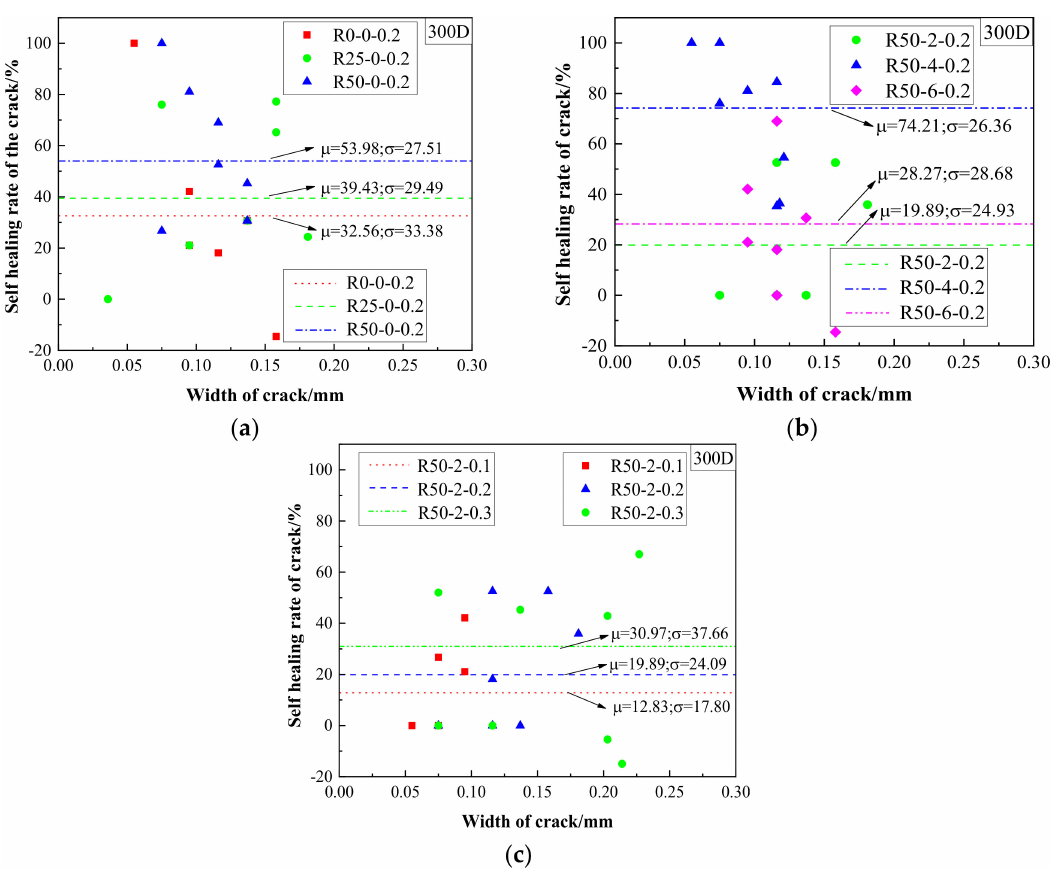
Figure 9. Self-healing rate of cracks in R0-0-0.2, R25-0-0.2 and R50-0-0.2 ( a ); R50-2-0.2, R50-4-0.2 and R50-6-0.2 ( b ); R50-2-0.1, R50-2-0.2 and R50-2-0.3 ( c